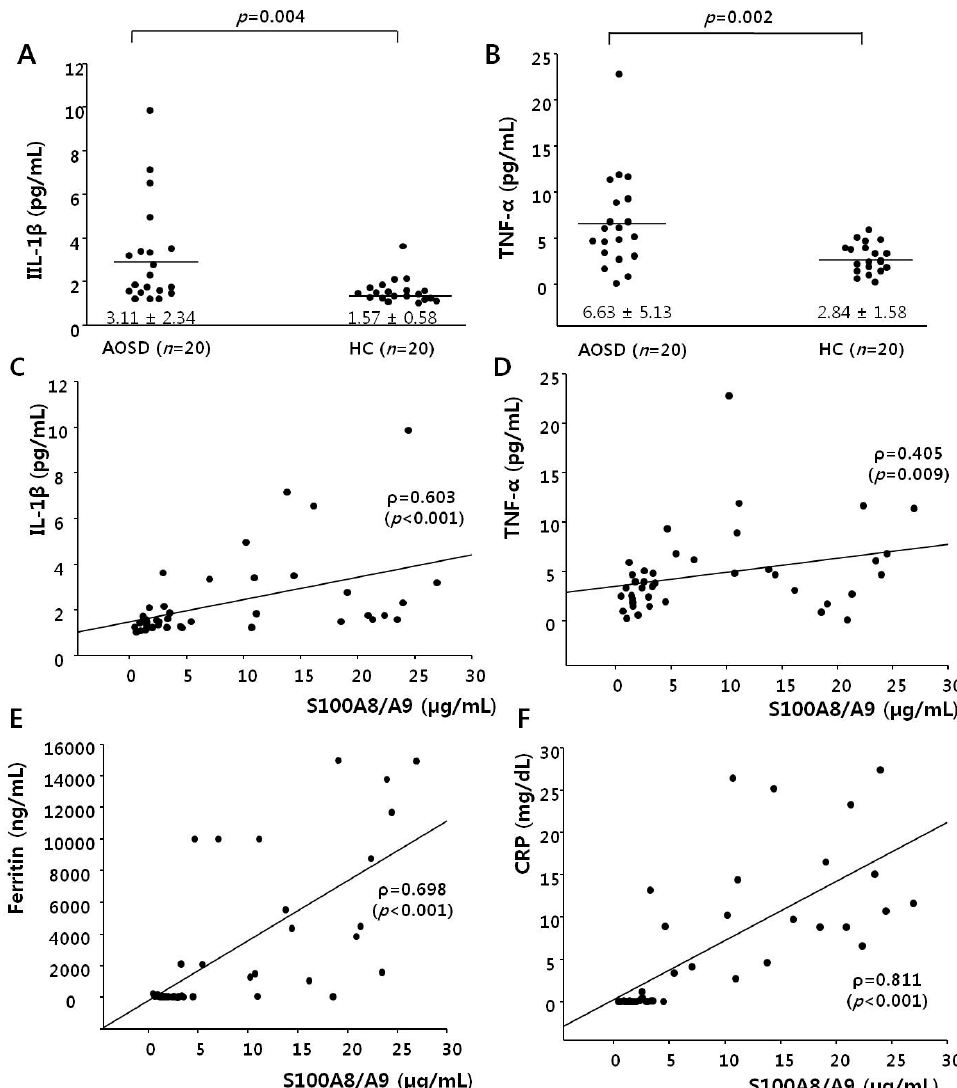
Figure 2. Levels of inteleukin-1 β (IL-1 β ) ( A ) and tumor necrosis factor- α (TNF- α ) ( B ) in 20 patients with active adult-onset Still’s disease (AOSD) and 20 healthy controls (HCs). Data are shown as the means ± SD. A Mann-Whitney U -test was performed for the statistical analysis. Serum S100A8/A9 levels correlated positively with IL-1 β ( r = 0.603, p < 0.001) ( C ), TNF- α ( r = 0.405, p = 0.009) ( D ), ferritin ( r = 0.698, p < 0.001) ( E ), and C-reactive protein (CRP) ( r = 0.811, p < 0.001) ( F ). These data were assessed using Spearman’s correlation.